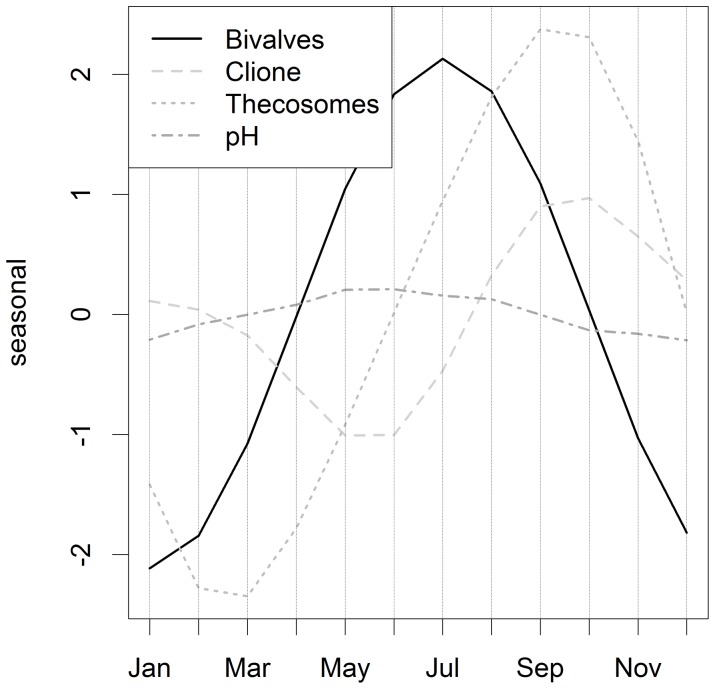
Seasonality in pH, bivalve, Clione and thecosome abundance in ICES area 4B (i.e. output from models 1,2,3 & 4).